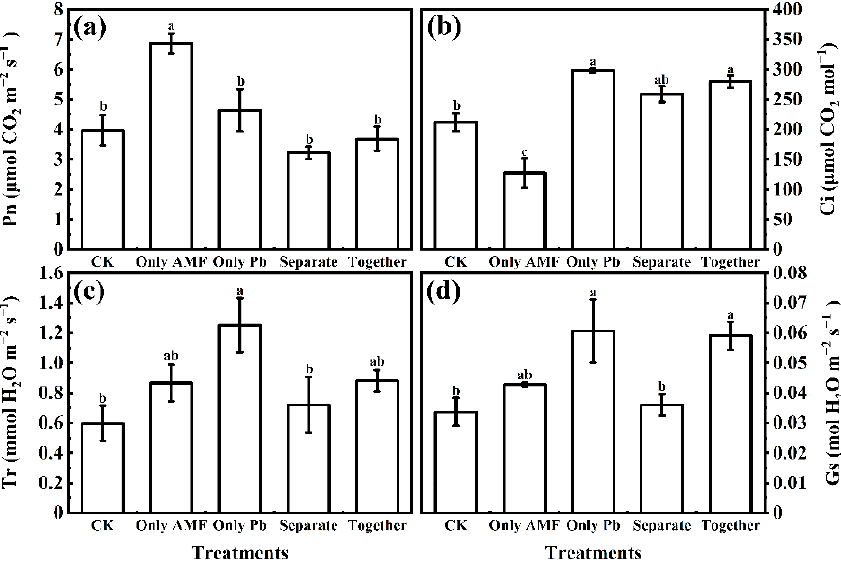
Figure 5. Effects of Pb and R. irregularis inoculation on net photosynthetic rate Pn ( a ), intercellular